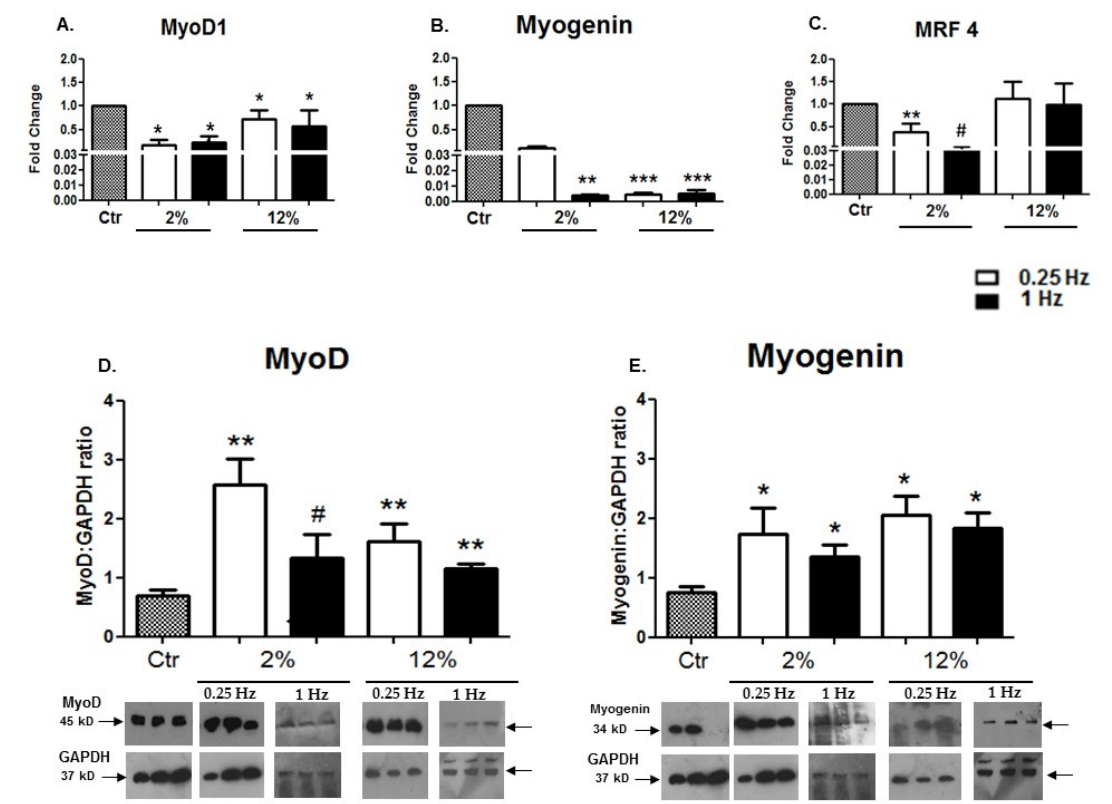
Figure 3. ( A – C ) Effects of cyclic mechanical loading on the expression of myogenic regulatory factors (MRFs). Quantitative analysis of transcriptional responses of ( A ) MyoD1, ( B ) Myogenin, and ( C ) MRF4 in differentiated cardiomyocytes subjected to different mechanical stretching protocols compared to the control (Ctr; nonstretched myotubes). ( D , E ) The mRNA values of MRFs in stretched myotubes have been normalized to the corresponding GAPDH mRNA and are expressed as fold changes compared to the control. Representative Western blots and immunoblotting quan- tification of MyoD ( D ) and Myogenin ( E ) subjected to the various mechanical loading conditions compared to the control; the proteins of interest were normalized to each corresponding GAPDH on the same immunoblot. The same blots have been used for GAPDH in Figure 3 D,E, in Figure 5C, and in Figure 7A,B, except from the blot of GAPDH in panel A for the 2%/1 Hz stretching protocol. Significantly different compared to the control, * p < 0.05; ** p < 0.01; *** p < 0.001. Significantly dif- ferent compared to the 2%/0.25 Hz stretching protocol, # p < 0.05. Mean + SE of three independent experiments performed in triplicate.